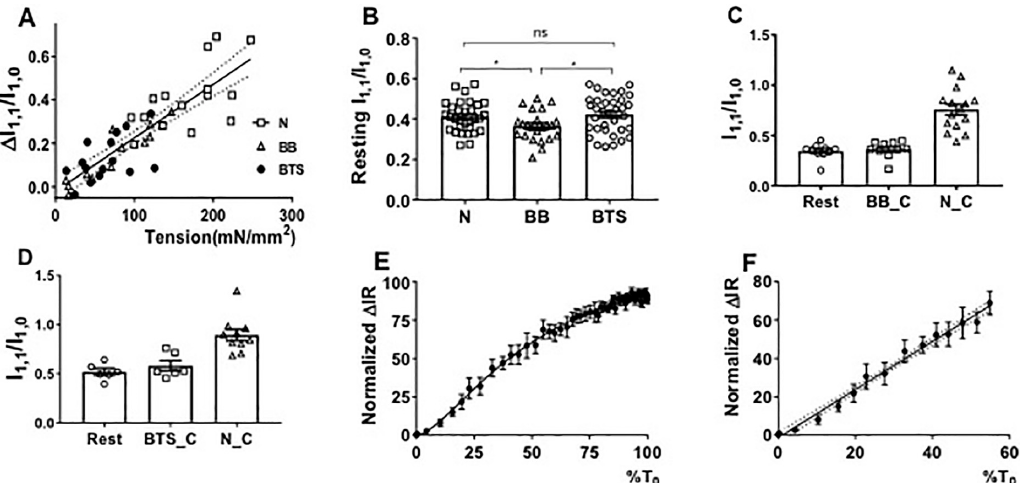
Figure 5. Equatorial intensities in active and resting mouse EDL muscle. ( A ) The change in I 1,1 /I 1,0 ( Δ I 1,1 /I 1,0 ), has a linear relationship with the tension generated by blebbistatin ‐ treated (BB), BTS ‐ treated (BTS), and normal contracting muscle (N). ( B ) I 1,1 /I 1,0 in resting normal muscle (from Figure 3B), blebbistatin ‐ treated (BB), and BTS ‐ treated muscle. ns: p ≥ 0.05, *: p < 0.05. ( C ) Intensity ratio changes from resting to contracting conditions at maximum inhibited (less than 10% of normal contraction